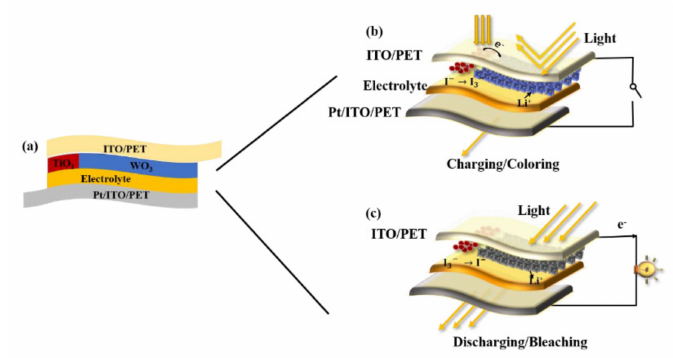
Figure 10. Schematic diagrams of the photoelectrochromic device (PECD): ( a ) photo-charging process of the PECD, and ( b ) the discharging process of the PECD ( c )